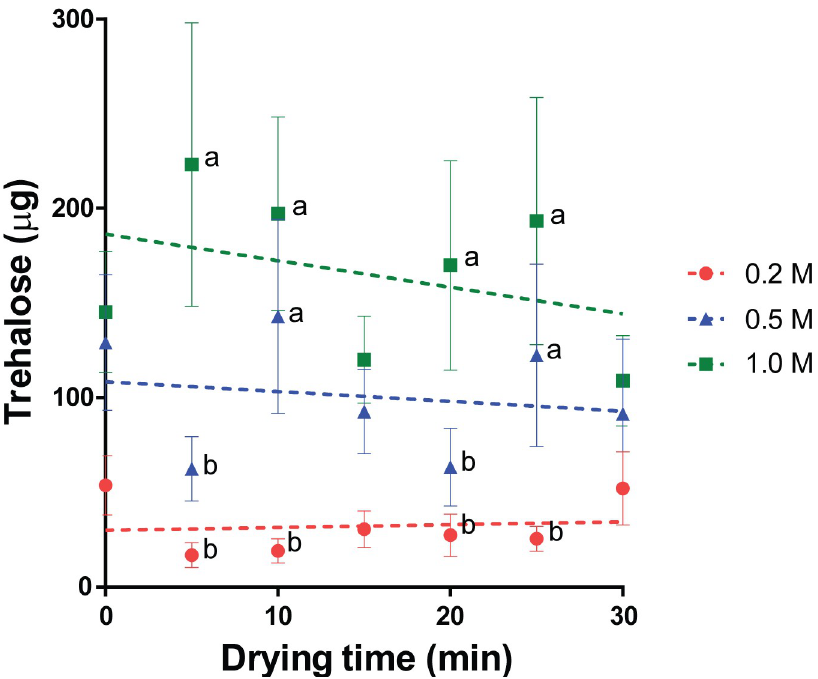
Fig 3. Trehalose content in tissues during microwave drying. Values are mean ± SEM. Two-way ANOVA analysis indicated significant effect ( P < 0.05) of trehalose concentration, but not drying time, on trehalose content. Samples treated with same concentration of trehalose exhibited no significant differences ( P > 0.05) over different drying time. At each time point, values with different letters differ ( P < 0.05) among groups exposed to different concentrations of trehalose at the same drying